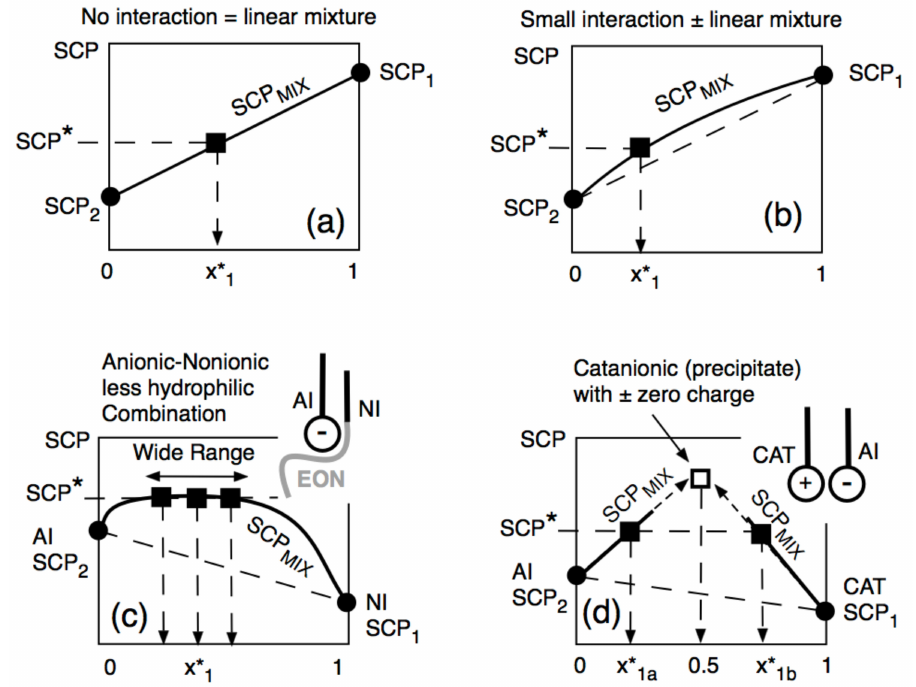
Figure 19. Variation of the surfactant contributing parameter SCP for di ff erent kinds of binary surfactant mixtures discussed in the text. ( a ) no interaction = linear mixture, ( b ) small interaction ± linear mixture ( c ) anionic-nonionic = less hydrophilic interaction and ( d ) catanionic (precipitate) with ± zero